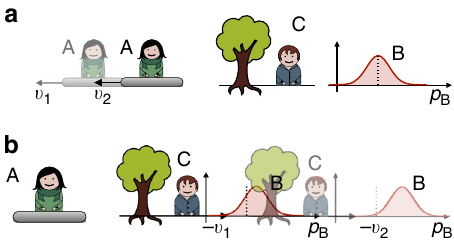
Fig. 5 Schematic illustration of the descriptions in two quantum reference frames that are boosted with respect to each other: a the state of A and B as described from C, and b the state of B and C as described from A. In a , the state of A and B is a product state, and the state of A is in a superposition of the two velocities v 1 and v 2 . By applying a ‘ superposition of boosts ’ by the velocity of A, we fi nd that, as seen from A, the state of B and C is entangled. In particular, the entanglement is such that if C moves with velocity − v i , i = 1, 2, from A ’ s point of view, B is boosted by − v